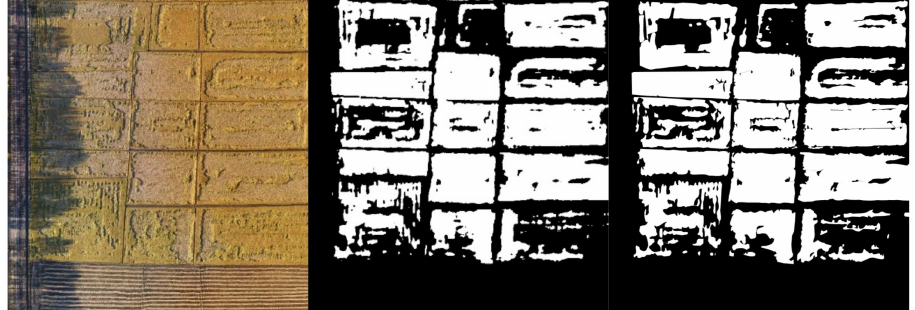
Figure 8. RGB original image ( left ), segmentation result image ( middle ) and manually processed ground image ( right